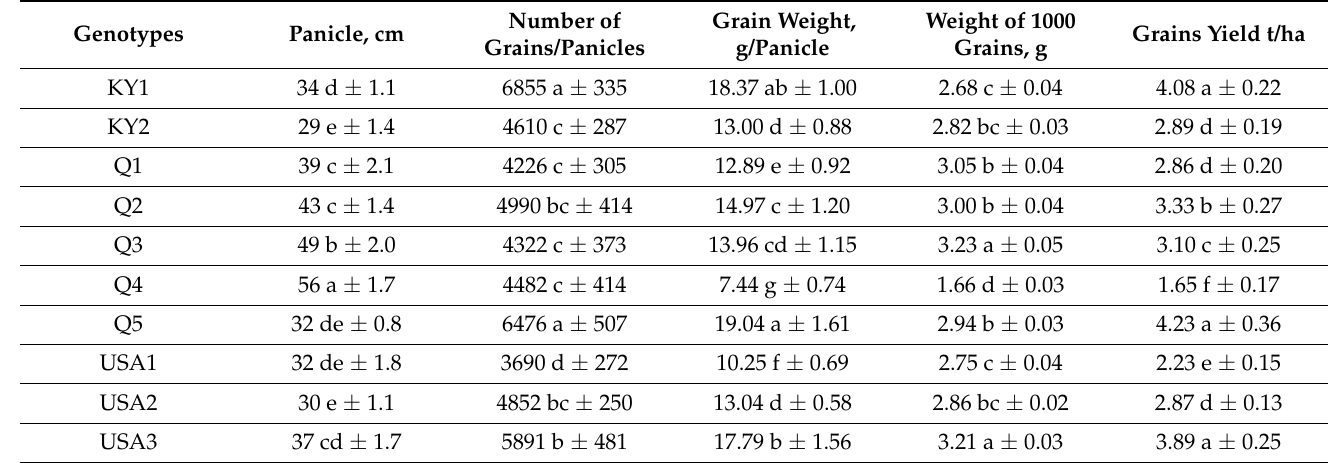
Table 4. Average yield and yield components of quinoa